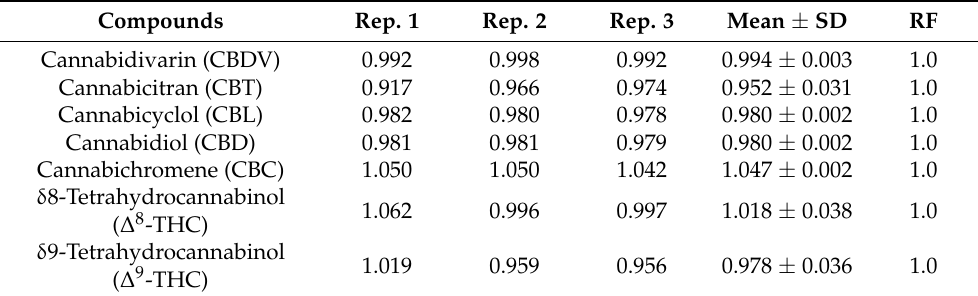
Table 3. Measurements of response factors (RFs) for different cannabinoid compounds. Compounds